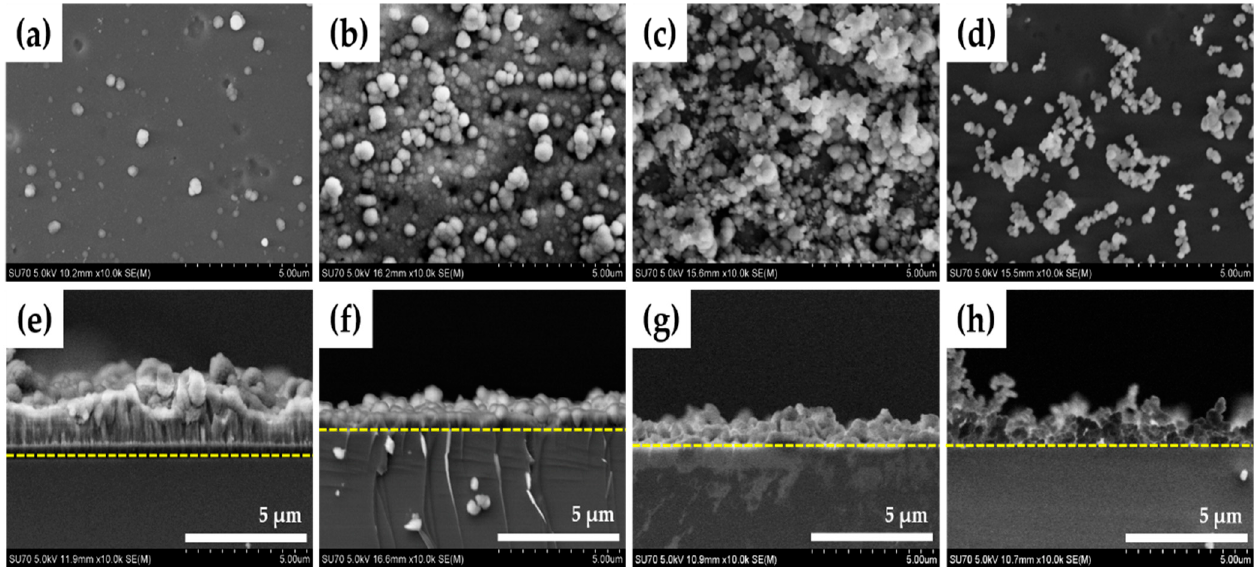
Figure 3. Top view ( a – d ) and cross section ( e – h ) FESEM images of the silicon oxide film deposited on the Si substrate using a quartz tube with the nozzle of diameters of ( a , e ) 5 mm, ( b , f ) 10 mm, ( c , g ) 15 mm, and ( d , h ) 20 mm.